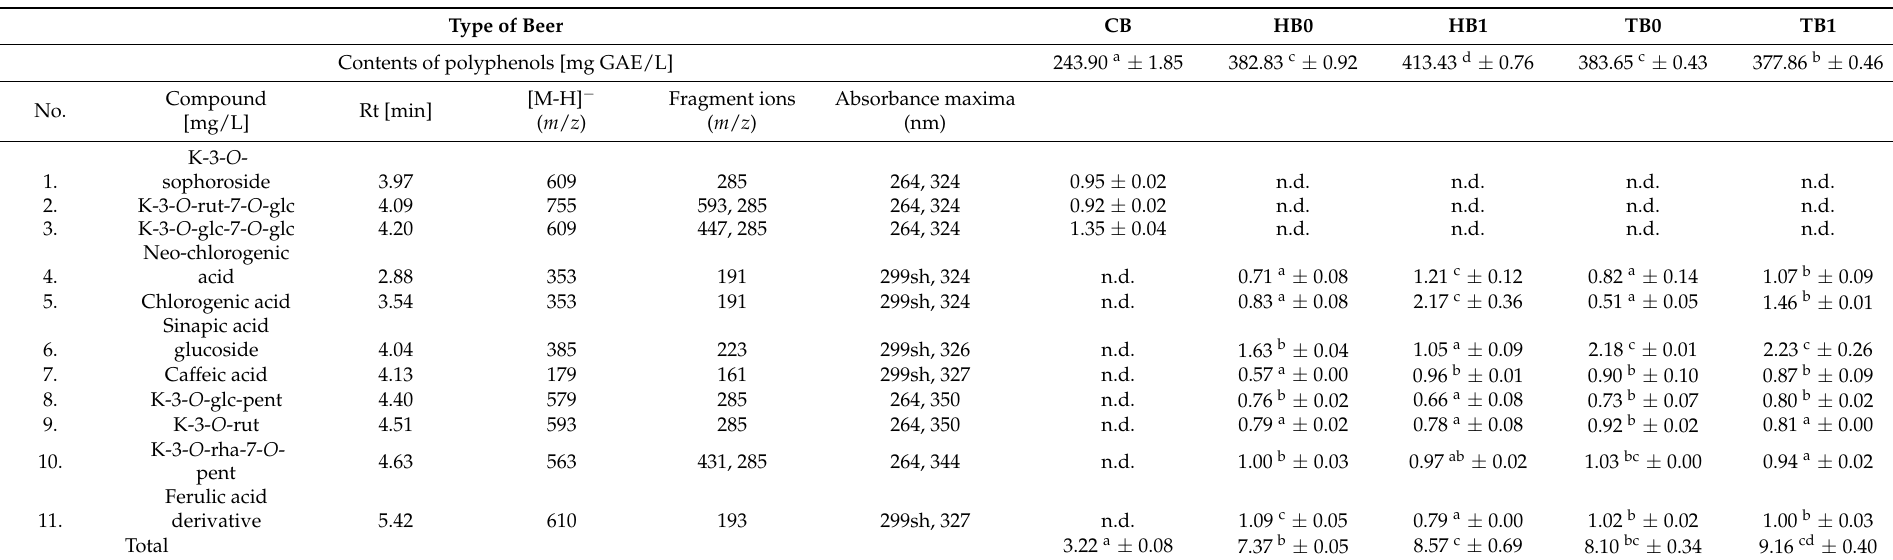
Table 3. Contents of polyphenols and polyphenolic profile identified by UPLC-PDA-TQD-MS in wheat